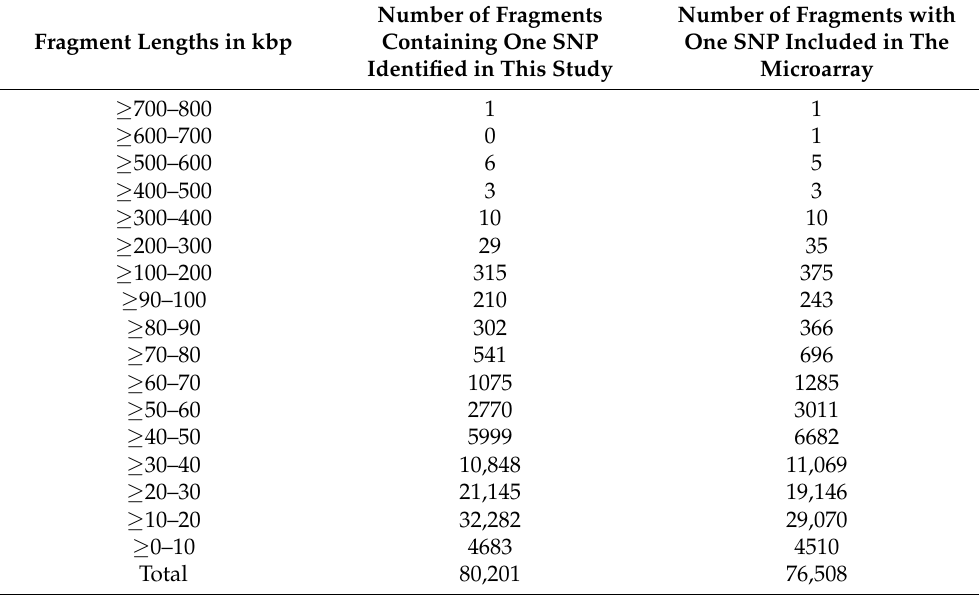
Table 3. Number of scaffold fragment lengths containing one SNP identified in this study and included in the